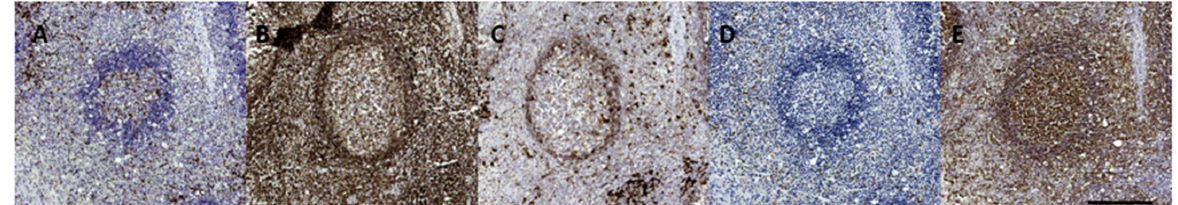
Figure 10. A histological image (HE stain) (274/18_R9). Detail of the cortical zone with a thin connective tissue capsule (A), a subcapsular sinus (B) with many erythrocytes, a follicle with mantle zone (C) and germinal centre (D), and parafollicular tissue (E) with a dense concentration of erythrocytes. Scale bar = 100 µm.